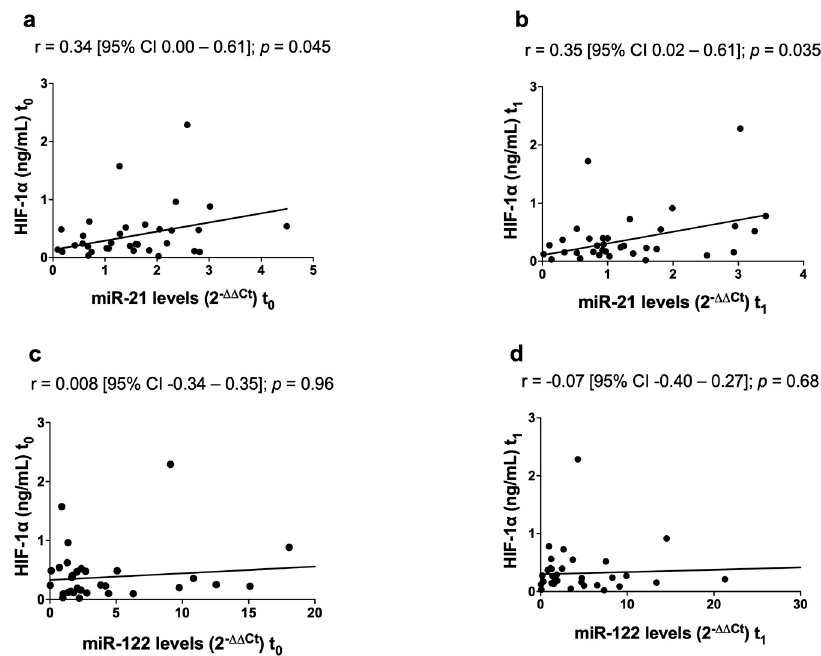
Figure 5. Correlations between the circulating levels of miR-21, miR-122 and HIF-1 α in HCC patients. miR-21 was positively correlated with HIF-1 α before ( a ) and after DEB-TACE ( b ). No statistically significant correlations were found between miR-122 and HIF-1 α , both before ( c ) and after DEB-TACE ( d ).